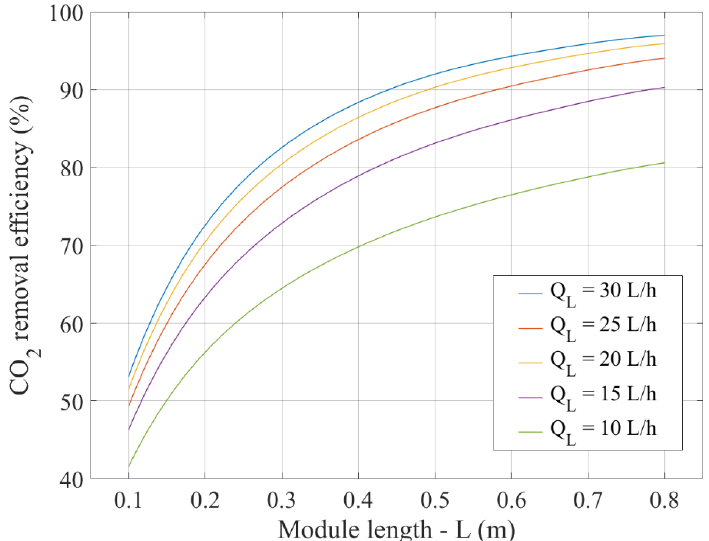
Figure 12. Effect of the module length on the CO 2 removal efficiency at different liquid flow rates, Q G = 2L · min − 1